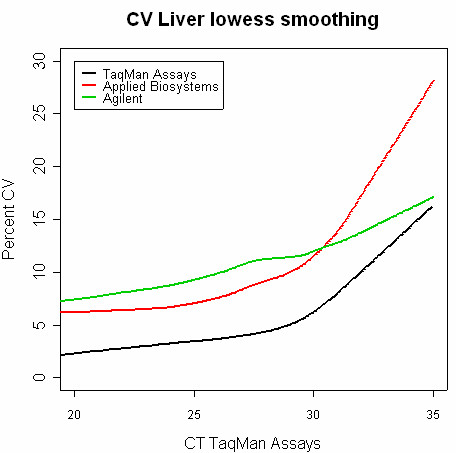
Coefficients of variation (CV) for the two microarray platforms and TaqMan® Gene Expression Assay based real-time PCR. The CV of 1,375 genes analyzed by all three platforms is plotted as a function of gene expression level. The lines represent lowess smoothing fitting curves to the 5,500 data points in each platform.